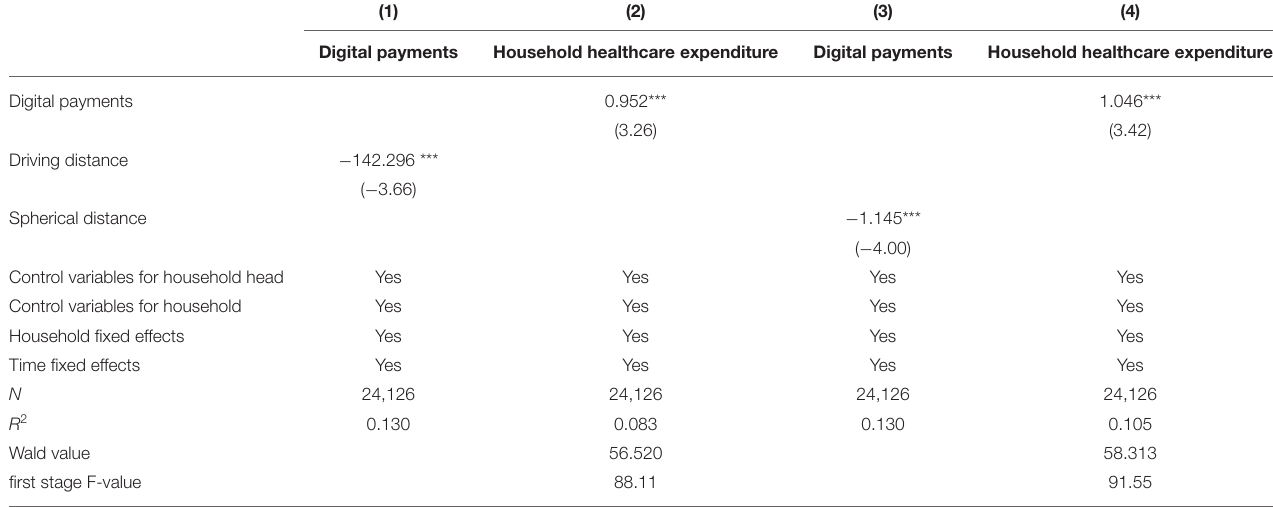
TABLE 3 | Robustness test: endogeneity treatment.